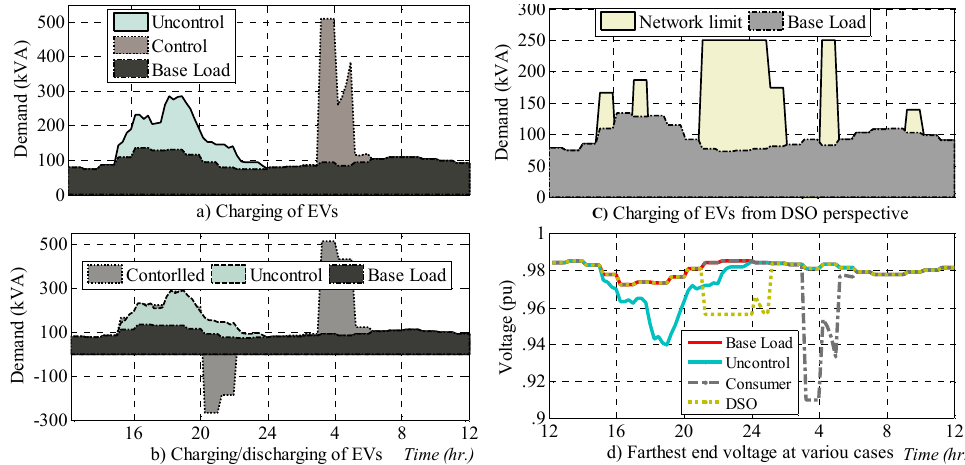
Figure 11. ( a ) Grid-to-vehicle (G2V) from consumer perspective; ( b ) vehicle-to-grid (V2G) from consumer perspective; ( c ) DSO perspective; and ( d ) farthest end voltage at various cases.